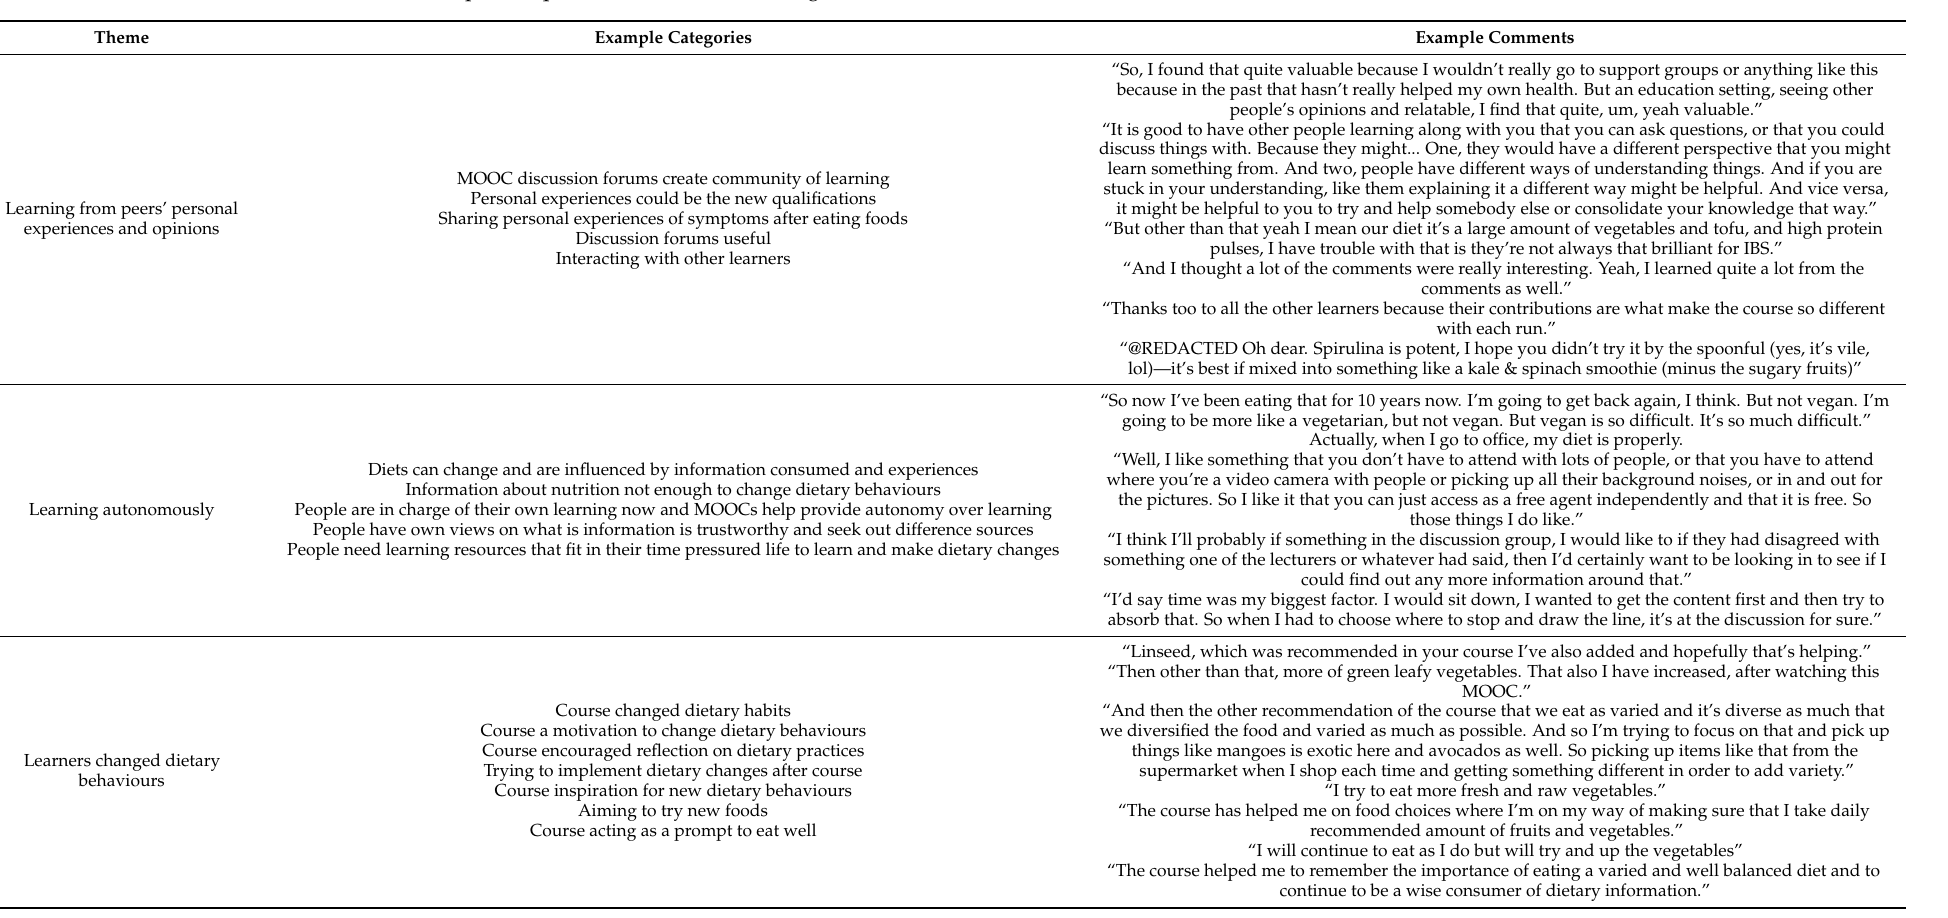
Table A5. Examples of qualitative themes and